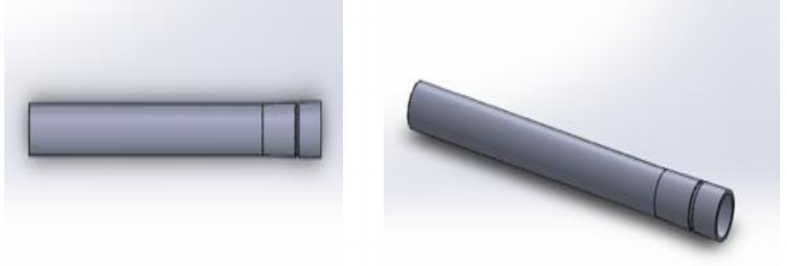
Figure 5. Final version of geometric lymphatic vessel wireframe model with valve at the ends (2020).